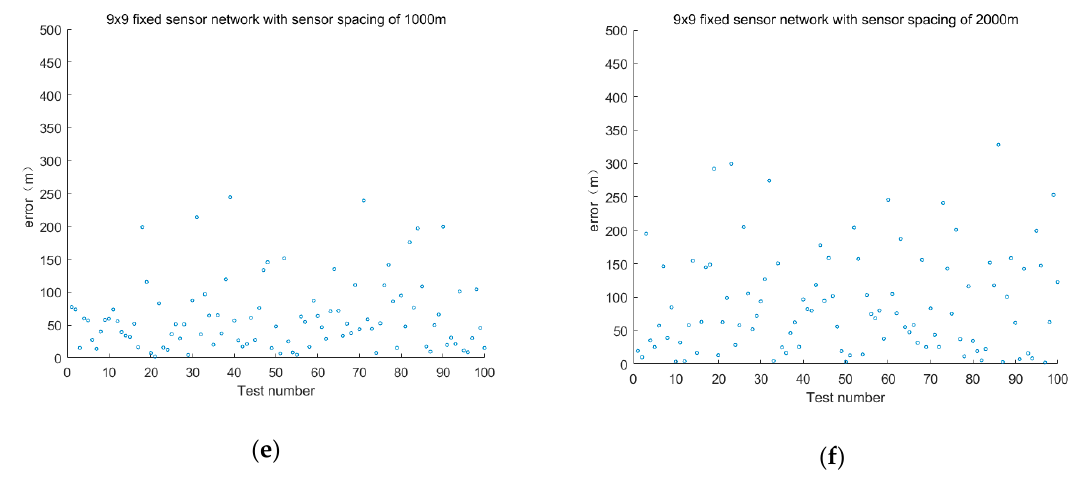
Figure 5. Positioning the error of different sensor spacings with the same layout.